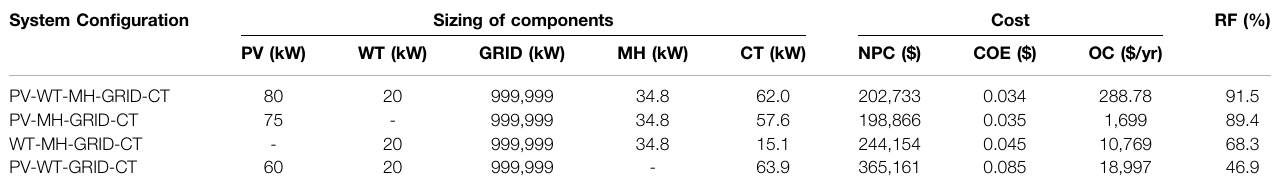
TABLE 3 | Performance of optimized results of HRES for ON Grid Scenario. System Con fi guration